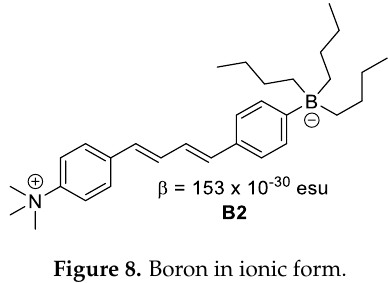
Figure 7. Boron forming an adduct with nitrogen. Figure 6. Boron in neutral form. Figure 8. Boron forming an adduct with nitrogen.